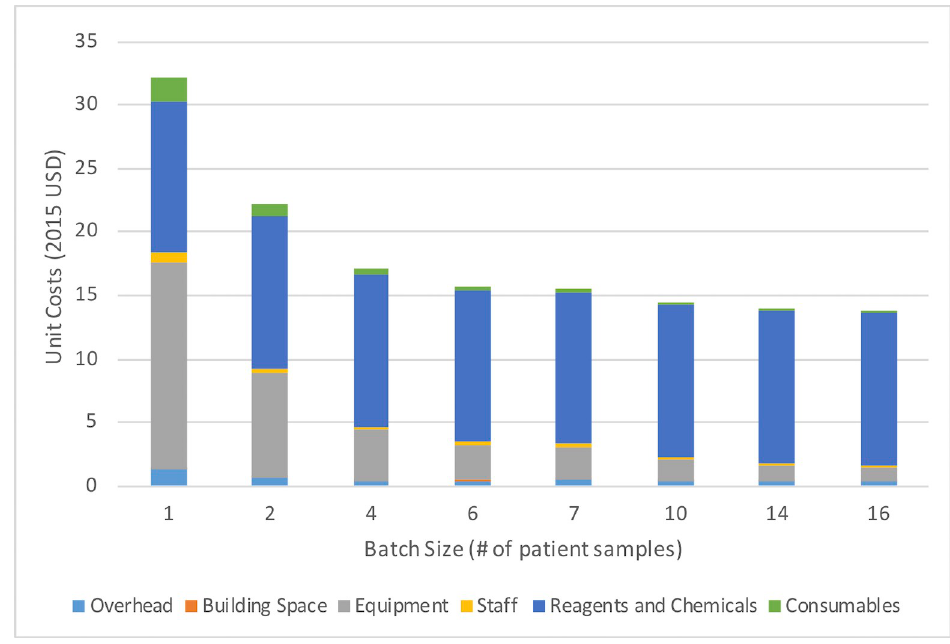
Fig 1. Reference Xpert per test costs for different testing workloads (batch size) categorized by type of resource inputs (New Delhi Tuberculosis Centre). Overhead includes electricity, gas, water, cleaning services etc. as well as staff involved in running the laboratories who were not employed by the FIND/RNTCP pediatric Xpert implementation project. Building space includes rent for rooms used for Xpert testing. Equipment includes the Xpert machine and other lab equipment. Staff includes wages for lab and managerial staff. Regents and chemicals consists of Xpert cartridge costs. Consumables include lab gloves and other personal protective equipment.